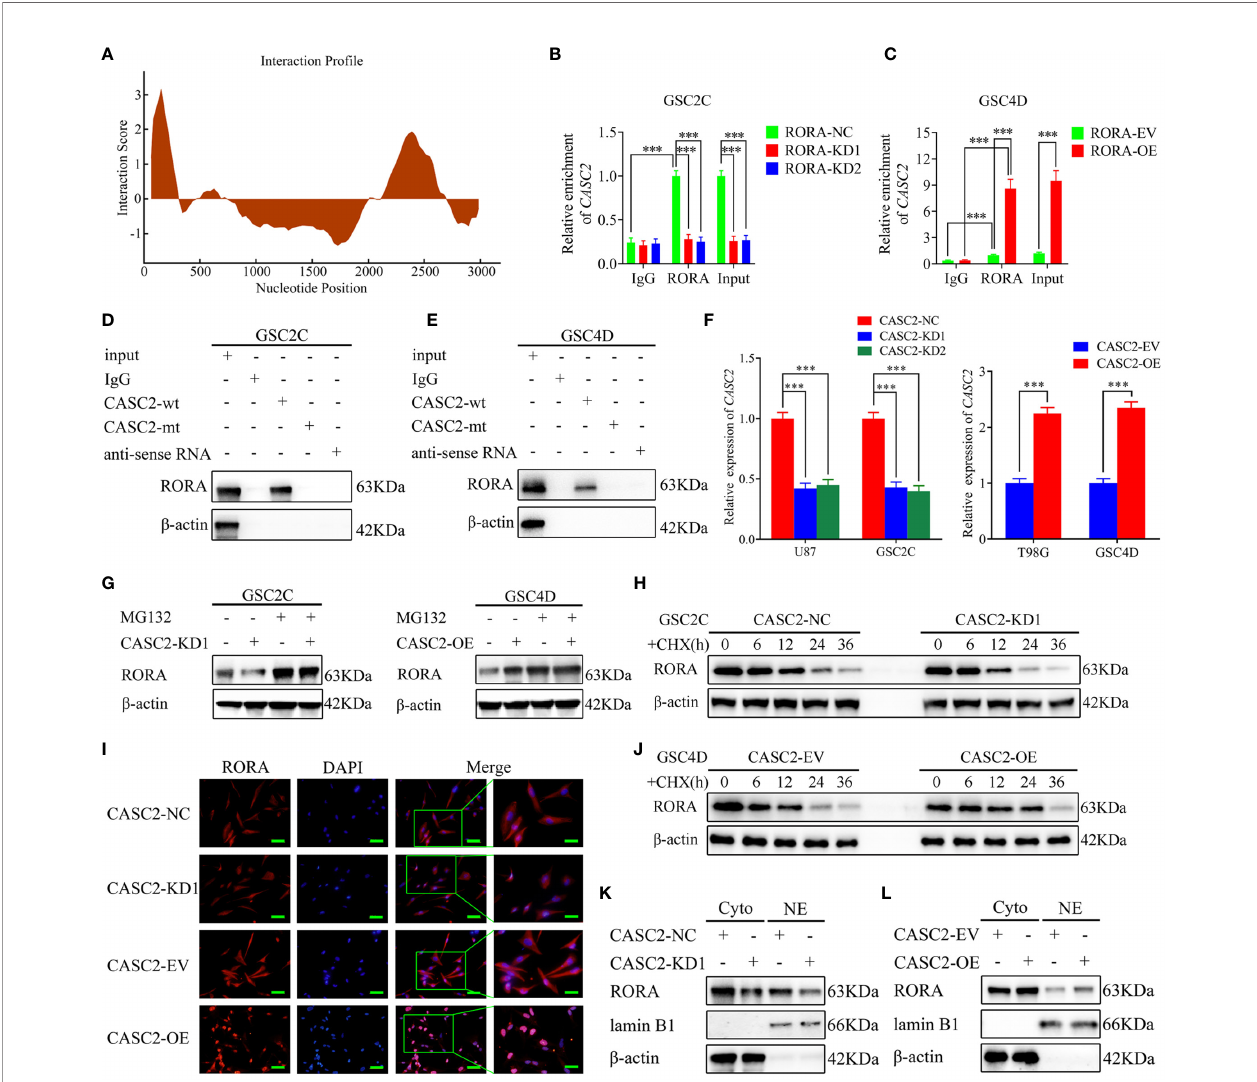
FIGURE 4 | LncRNA CASC2 binds to and maintains the stability of RORA protein and promotes the nuclear translocation of RORA. (A) CatRAPID predicts that CASC2 can bind to RORA proteins. (B, C) The RNA immunoprecipitation (RIP) assay was performed in GSC2C or GSC4D after RORA knockdown or overexpression, and negative control was transfected, followed by q-PCR to detect the enrichment of CASC2 and RORA. (D, E) The RNA pull-down assays showed the RORA protein immunoprecipitation with CASC2 as detected by western blotting. (F) qPCR showing the validation of CASC2 knockdown or overexpression. (G) CASC2-silenced GSC2C, and CASC2-overexpressed GSC4D and their control were treated with or without MG132 (50 µM) for 6 h, then, cell lysates were detected by western blotting with indicated antibodies, b -actin was used as the control. (H, J) CASC2-silenced GSC2C, and CASC2-overexpressed GSC4D were treated with cycloheximide (CHX, 100 ng/ml) to indicate periods of time, and cell lysates were detected by western blotting to indicate the half-life of RORA protein. (I) Representative images of subcellular localization of RORA in CASC2-silenced GSC2C and CASC2-overexpressed GSC4D were shown by immuno fl uorescence. Scale bars=50 µm. (K, L) Nuclear and cytosolic lysates were extracted from CASC2-silenced GSC2C and CASC2-overexpressed GSC4D, followed by western blotting with indicated antibodies. EV, empty vector; OE, overexpression; NC, negative control; KD, knockdown. All data are expressed as the mean ± SD (three independent experiments). ***P <